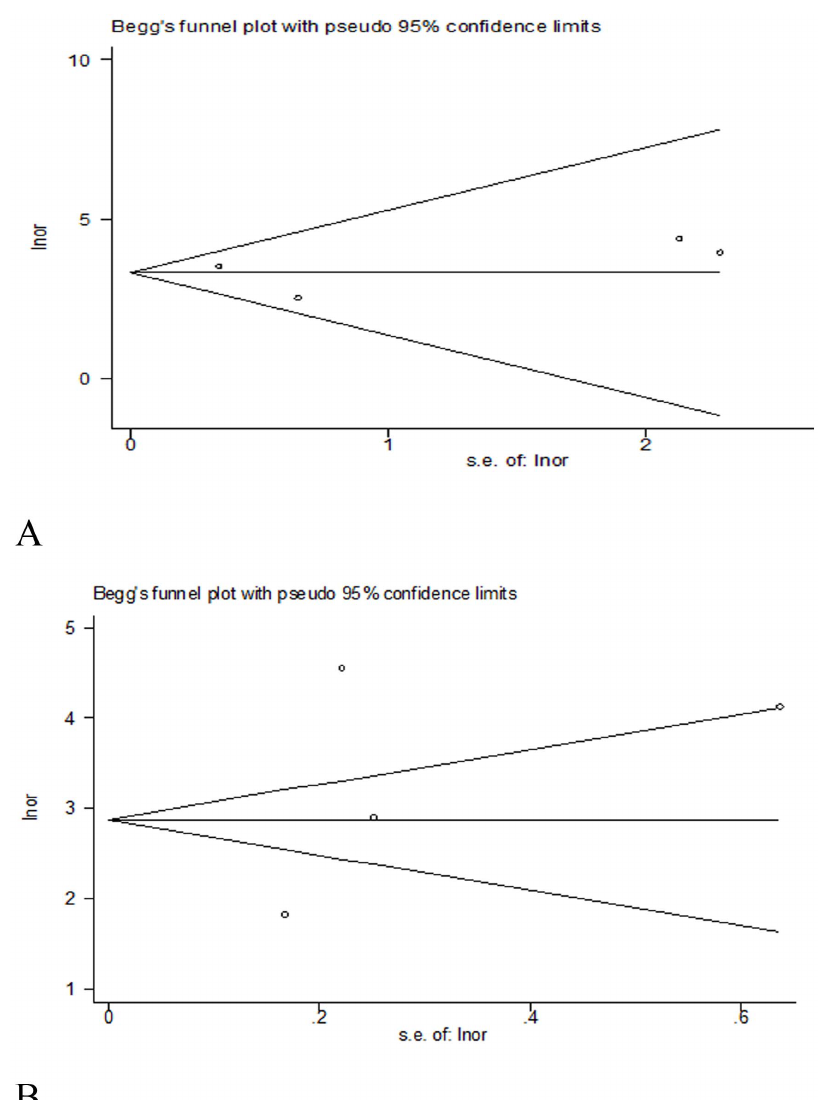
Figure 6. Funnel plot was constructed by Begg’s and Egger’s test to evaluate publication bias. A. Begg’s test for the studies differentiating GIM on a per-patient analysis; B. Begg’s test for the studies differentiating GIM on a per-lesion analysis. Lnor, ln [(TP*TN)/(FP*FN)]; s.e.of:lnor, (1/TP) + (1/FP) + (1/FN) + (1/TN).